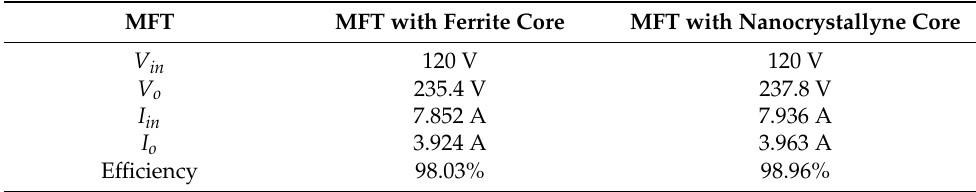
Table 8. Input and output voltages and currents for MFTs. MFT MFT with Ferrite Core MFT with Nanocrystallyne Core V in 120 V 120